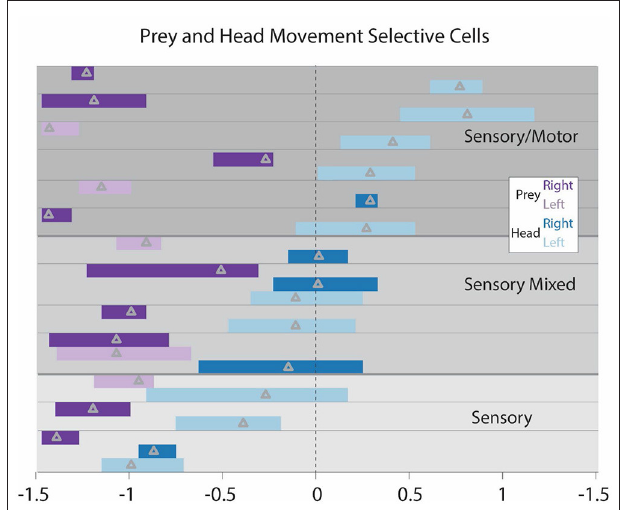
FIGURE 5 | STRF peaks for all cells that both respond to the target movement and respond relative to the praying mantis’s movement toward the target. Each cell’s peaks are positioned between horizontal lines. Cells are separated into 3 categories. Purely “sensory” cells (bottom 3) have target peaks and mantis head movements to the left. These are cells that respond to the appearance of the target and after the mantis initiates movement. “Sensorimotor” cells (top) have responses associated with target appearance to the left and mantis movement peaks exclusively to the right of 0. These are cells that increase activity with the appearance of the target and have activity significantly increased prior to the movement. “Sensori-mixed” cells (middle) have increased activity associated with target appearance and have increased activity associated with mantis head movement that substantially spans 0. These cells respond to the appearance of the target and have some activity prior to the initiation of mantis head movement that continues throughout the mantis head movement. It should be noted that one sensory and one sensorimotor cells have a slight overlap of the head movement peaks into the opposite region, but we regarded this overlap as minimal. These were subjectively placed in the categories indicated